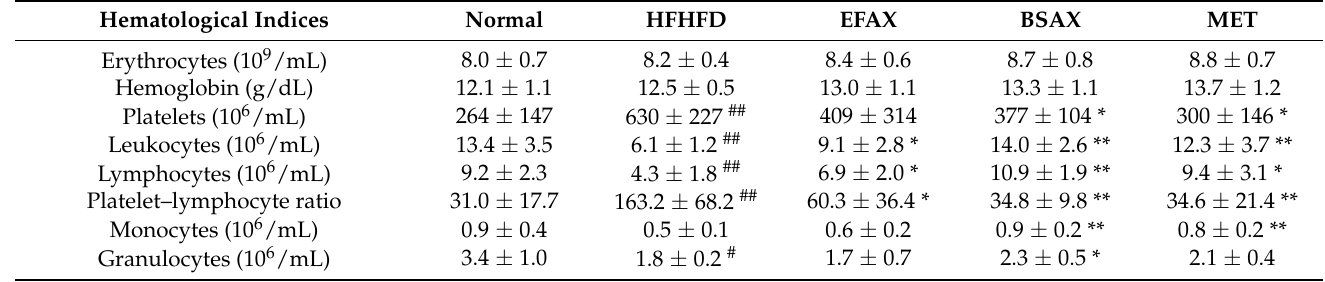
Figure 2. BSAX mitigated HFHFD-induced metabolic disturbance. ( A , B ) Final body weight (the body weight gain during the drug treatment is shown in yellow) and total white adipose tissue (WAT) weight were recorded on the last experimental day. ( C , D ) Serum triglycerides (TGs) and total cholesterol (TC) were determined using a Chemistry Auto Analyzer (Chiron, Emeryville, CA, USA). ( E ) After 18 h of fasting, fasting blood glucose (FBG) was detected using a drop of blood from the tail end. ( F ) Serum insulin levels were measured with the mouse insulin ELISA kit (Invitrogen, Carlsbad, CA, USA). # p < 0.05, ## p < 0.01, compared with the normal group; * p < 0.05, ** p < 0.01, compared with the HFHFD control. Table 2. Hematological